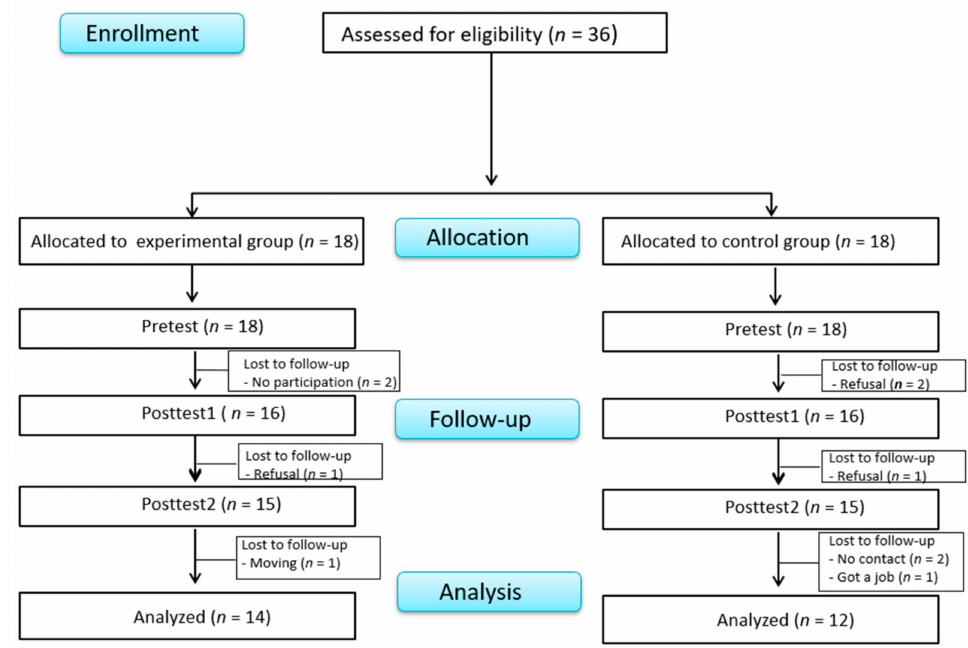
Figure 1. Flowchart of